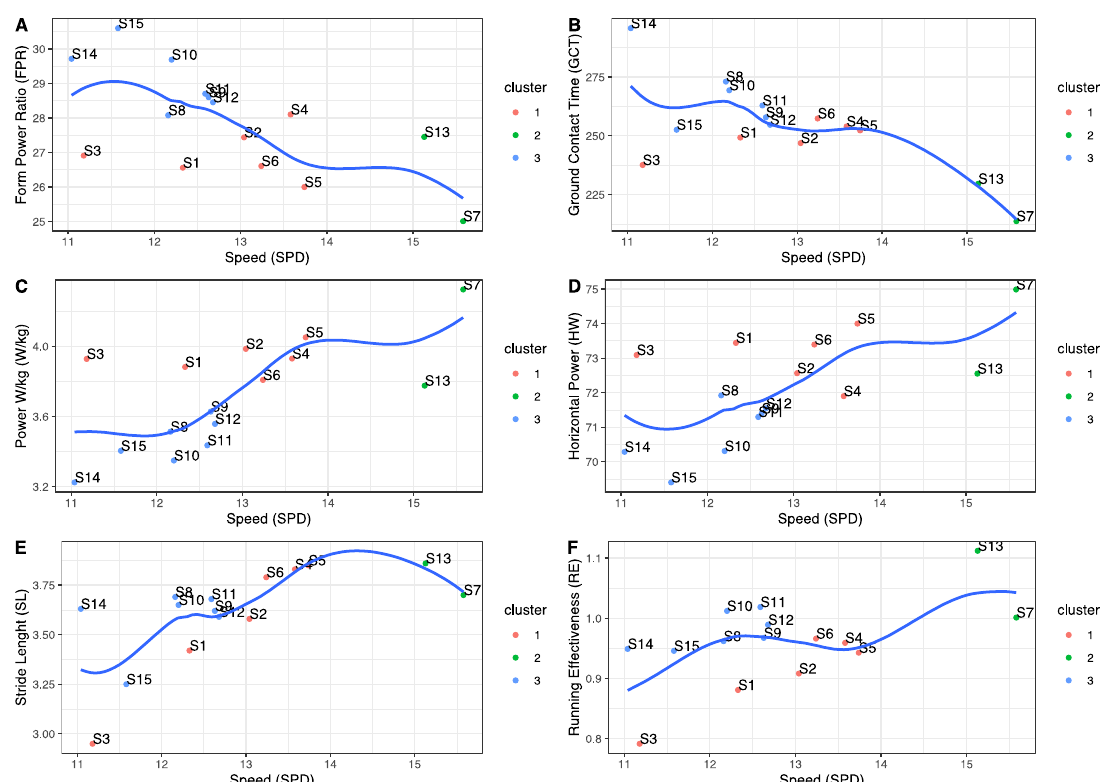
Figure 5. The relationship between speed and the variables that best correlated with it. ( A ) Form power ratio (FPR), ( B ) ground contact time (GCT), ( C ) power per kilogram (W/kg), ( D ) horizontal power (HW), ( E ) stride length (SL), and ( F ) running effectiveness (RE).